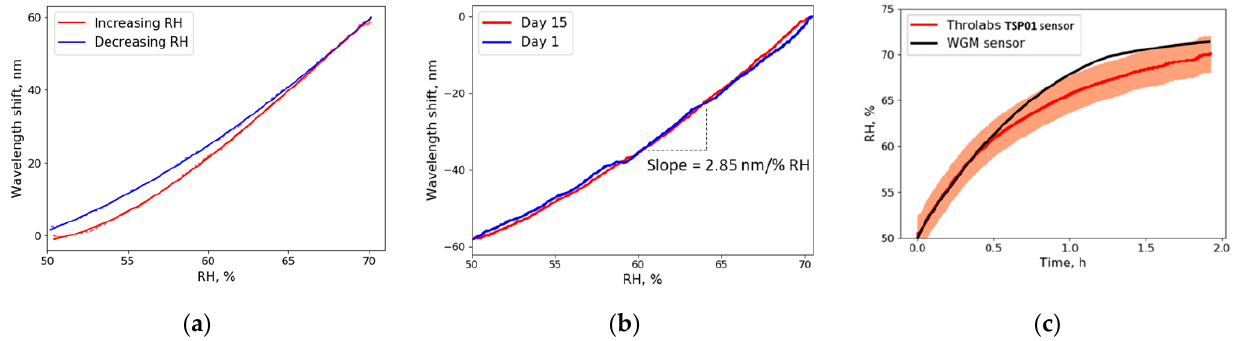
Figure 5. Recorded wavelength shift due to change in RH: ( a ) Humidity was slowly increased from 50% to 70% RH by using a saturated NaCl solution, which was placed inside the humidity chamber. Then NaCl was removed and humidity was reduced by circulating humid air through a container filled with silica gel desiccant. Continuous lines illustrate data fitted with the 3rd-order polynomial; ( b ) Wavelength shift recorded while reducing humidity on day 1 and day 15. The plot illustrates high repeatability and sensitivity (slope of the curves); ( c ) Comparison of TSP01 humidity sensor (Thorlabs) and proposed glycerol WGM sensor. The graph illustrates the measured RH values with both sensors. Humidity was slowly increased using saturated NaCl solution in the range 50–70% RH. The colored band represents the imprecision (±2% RH) of the Thorlabs sensor (see Section 2).